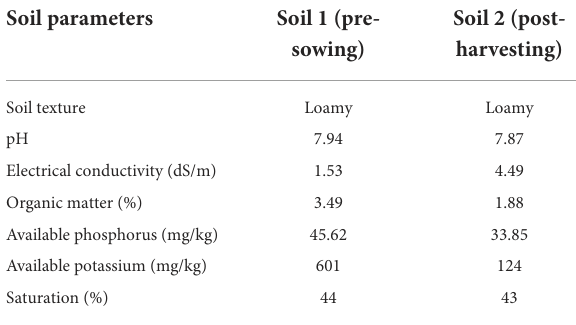
TABLE 1 Physio-chemical properties of